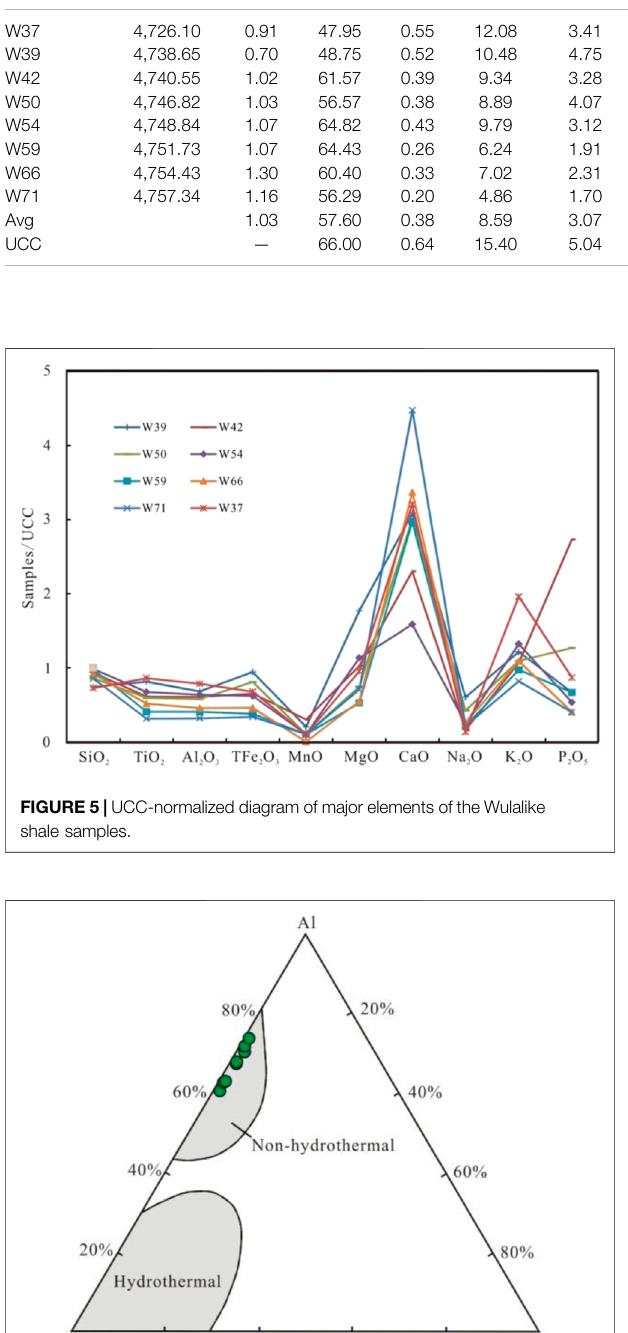
Frontiers in Earth Science |